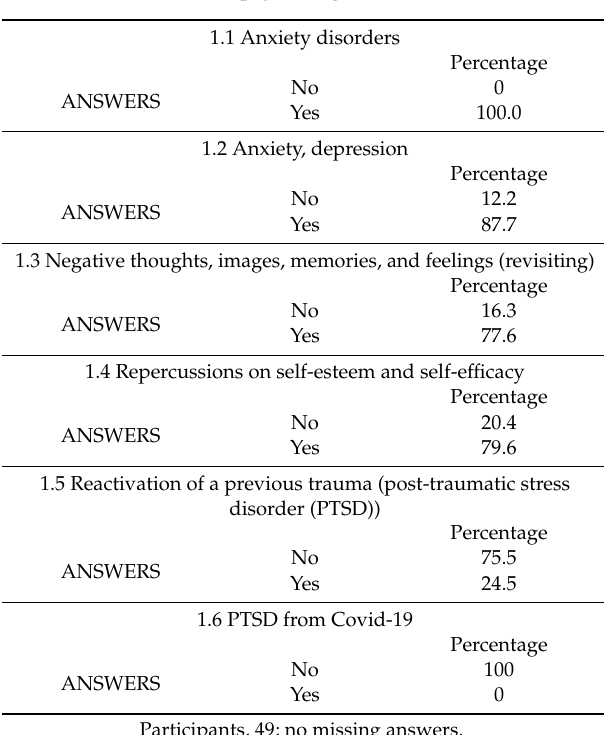
Table 1. Area 1: psychological